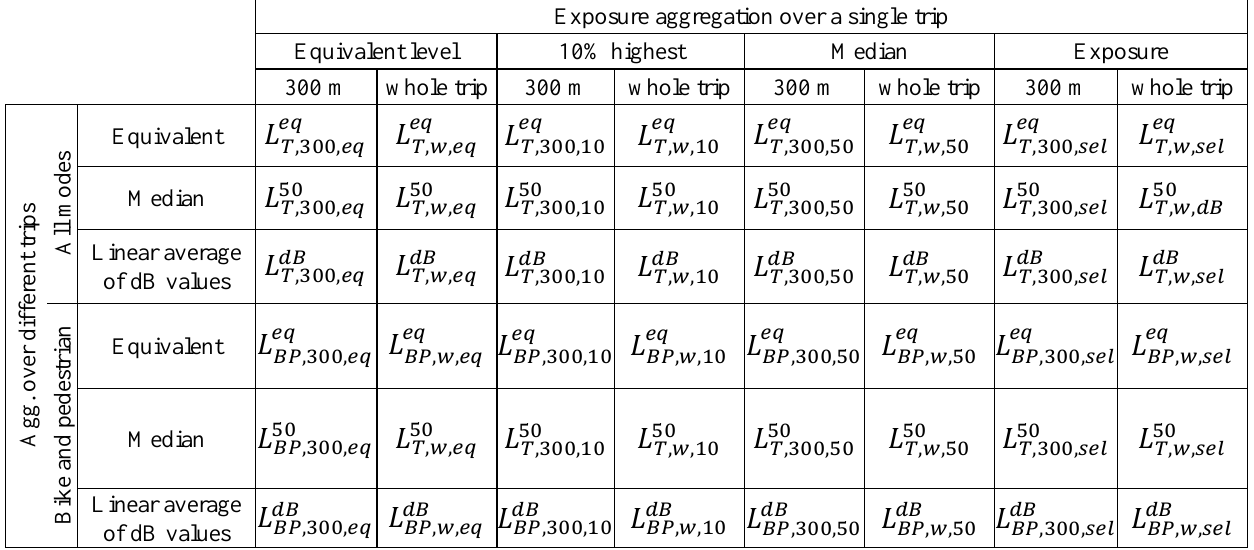
Table 1. Indicators for noise exposure during